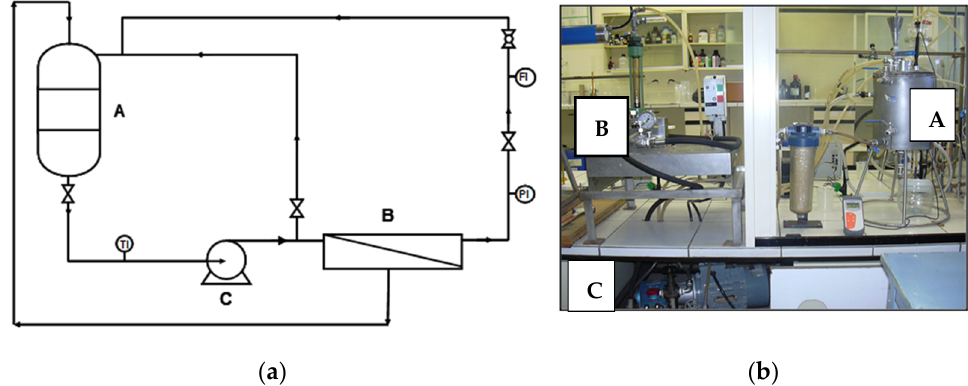
Figure 1. ( a ) Scheme of the membrane test module. ( b ) Picture of the membrane test module.